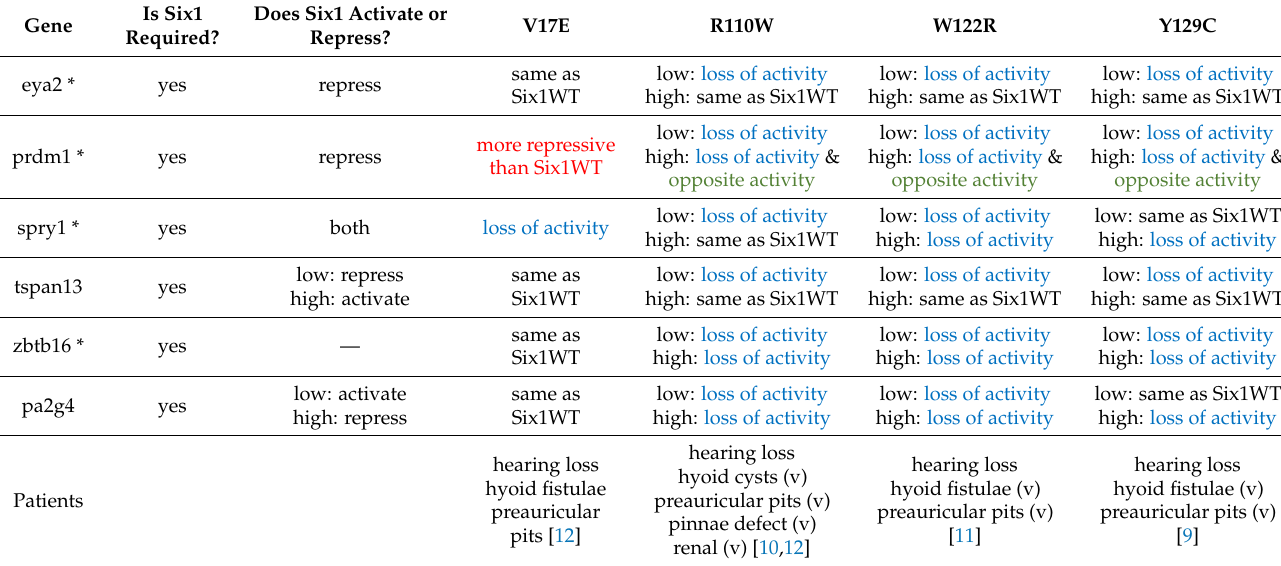
Table 2. Summary of effects Six1 on otic vesicle gene